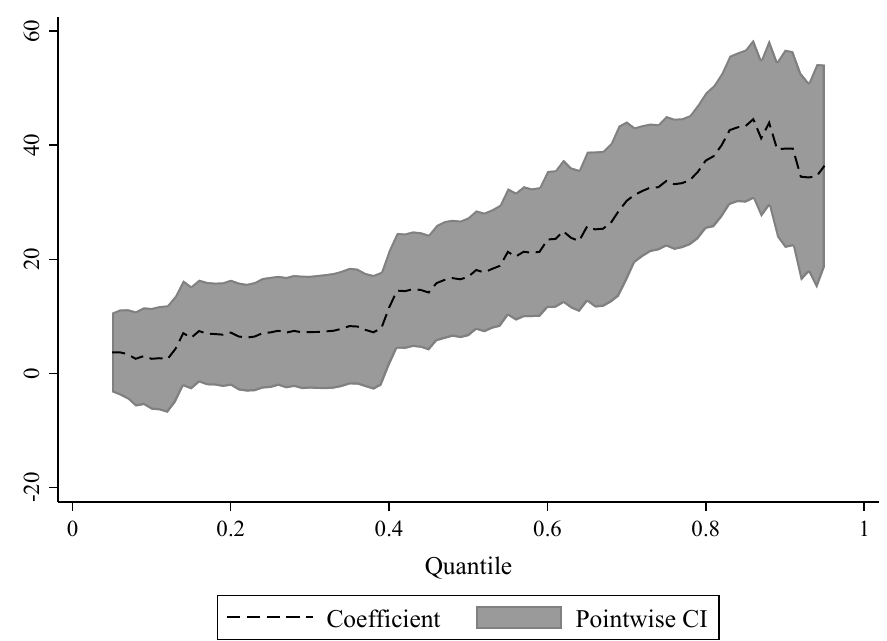
Figure 4. Distribution trend of DID coefficients in different quantiles.